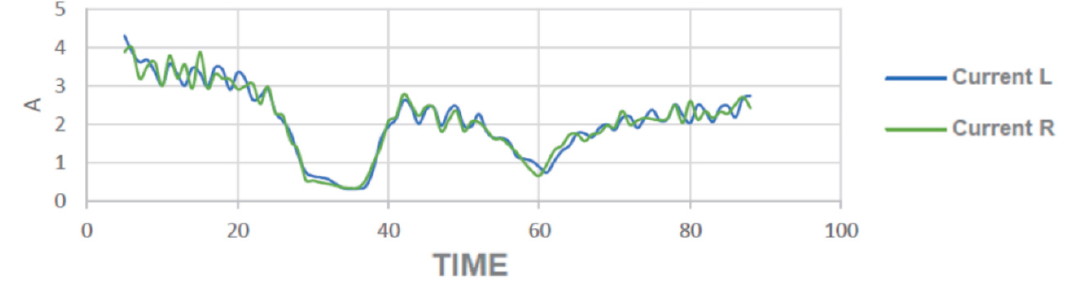
Figure 11. ED control results working adding a steering angle feedback at an average 5 Km/h doing sharp